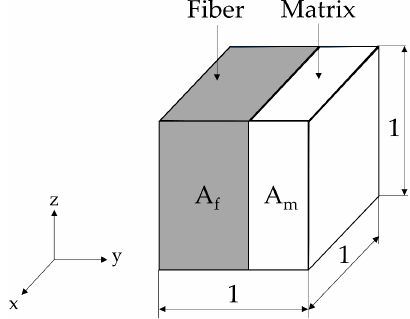
Figure 2. Schematic fiber-reinforced composite (cubic unit cell with dimensions 1 × 1 × 1).